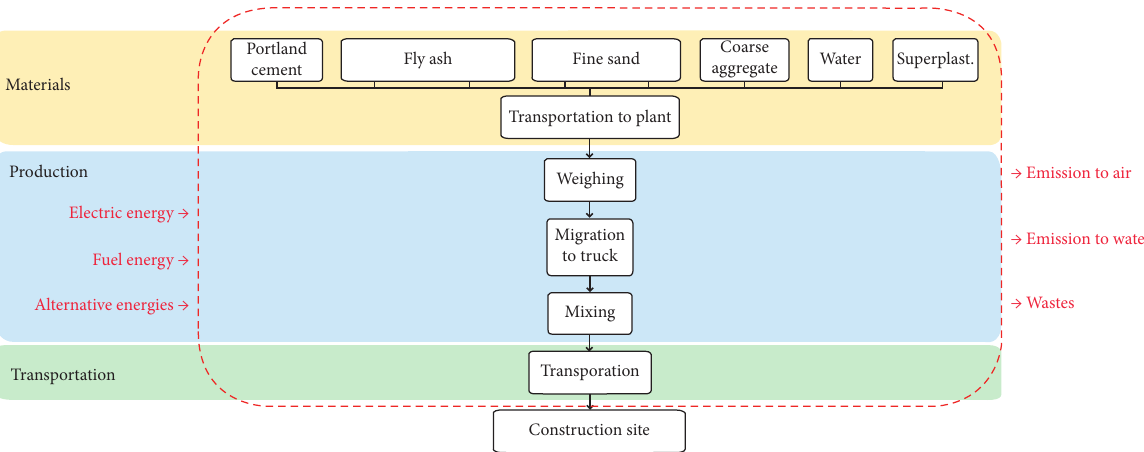
Figure 12: Schematic diagram of the cradle-to-gate approach LCA of HVFA concrete, reproduced from [39], with permission from Elsevier, 2021.